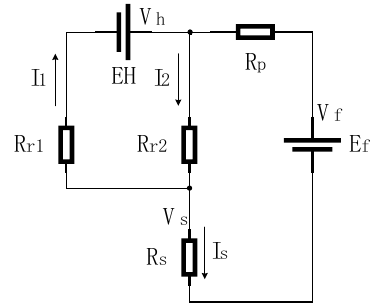
Figure 3. Principle of monitoring insulation resistance between the positive electrode and the chassis.